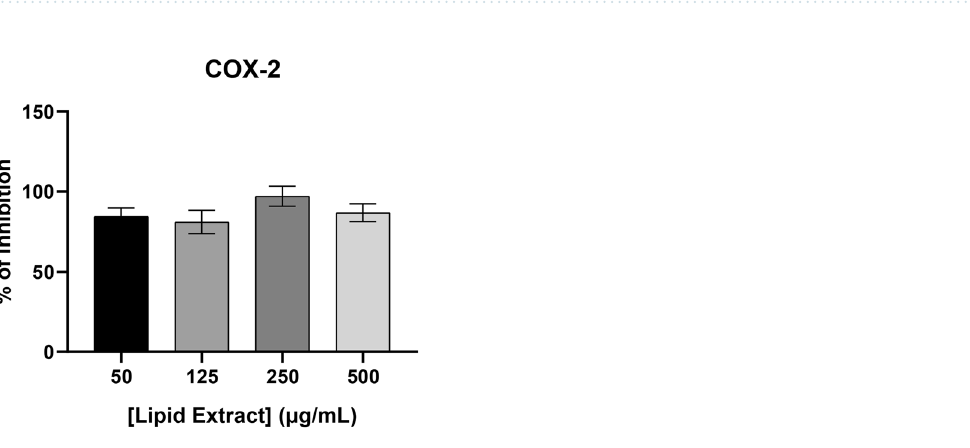
Figure 8. Percent inhibition of COx-2 as a function of the concentration of the lipid extracts of Chlorococcum